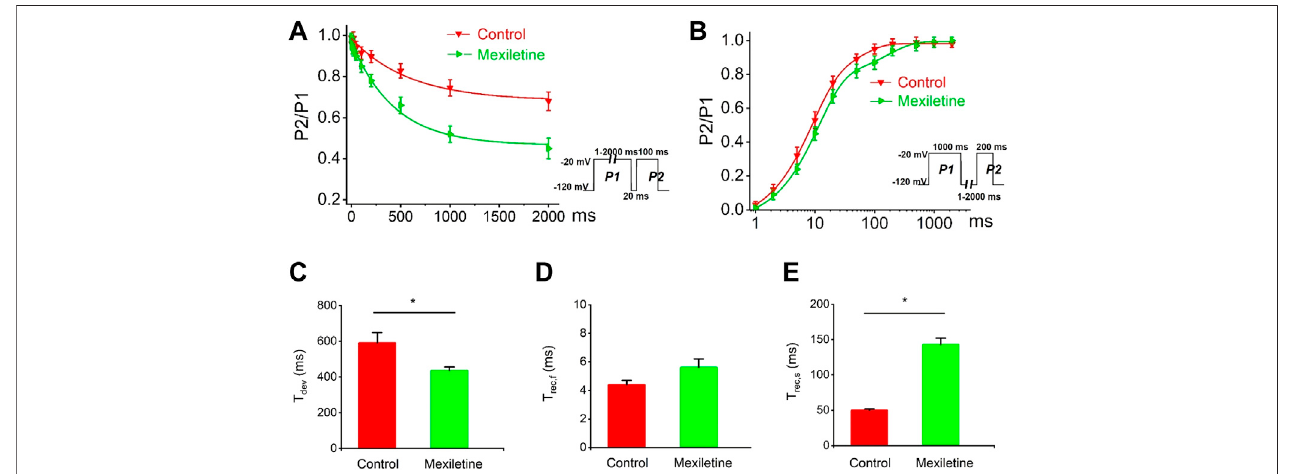
FIGURE7| EffectsofmexiletineonthedevelopmentandrecoveryofinactivationoftheP1090Lmutation. (A) .DevelopmentofinactivationforP1090Lmutationintheabsence (Control) or presence of 200 µM mexiletine was assessed by varying the duration of a conditioning pulse P1 (1 – 2000 ms) to − 20 mV followed by a return to − 120 mV for 20 ms followedbya100 mstestpulseP2to − 20 mV. (B) .RecoveryofinactivationforP1090Lmutationinthepresenceorabsenceofmexiletinewasassessedusinginsertprotocolwitha fi rstpulsedurationof1000 ms(P1)andasecond pulseof200 ms(P2) to − 20 mVwithvaryingrestintervalsfrom1to2000 msat − 120 mV.Curvesin (A,B) areexponential function fi tsofthedatapoints, n =8forControl, n =6forMexiletine;dataarepresentedasthemean±SEM. (C). Summaryoftimeconstantfordevelopment( Ʈ dev )forcontrolgroup and mexiletine group. (D) . Summary of time constant for fast recovery ( Ʈ rec,f ) for control and mexiletine. (E) . Summary of time constant for slow recovery ( Ʈ rec,s ) for control and mexiletine. Data are presented as the mean ± SEM. * p <